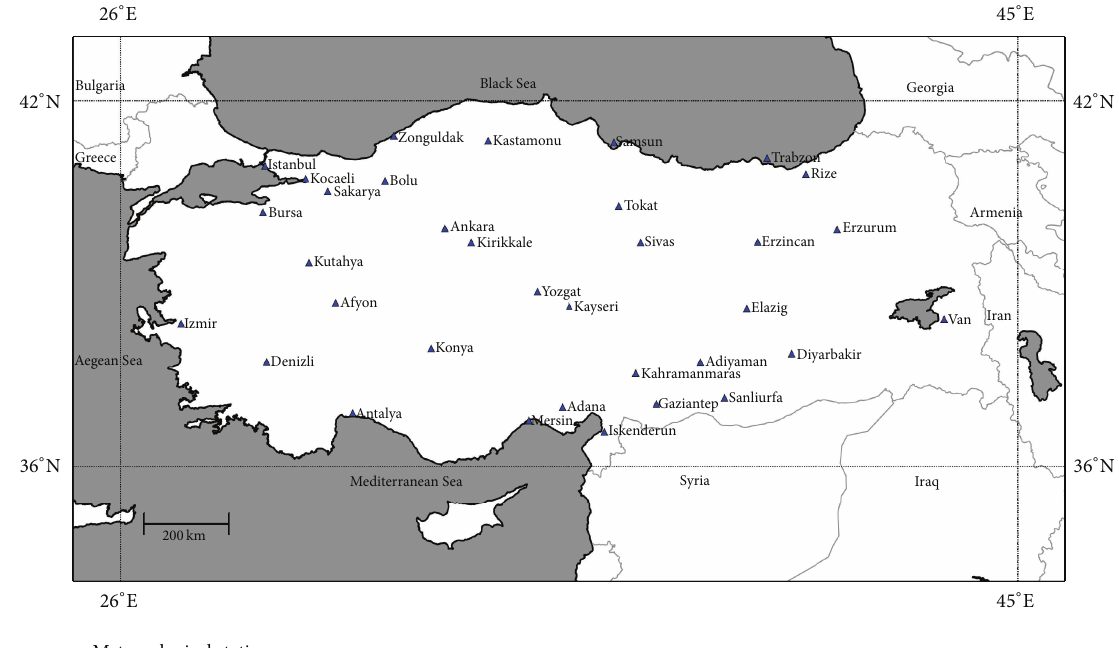
Figure 1: The geographical distributions of 34 meteorological stations in Turkey.